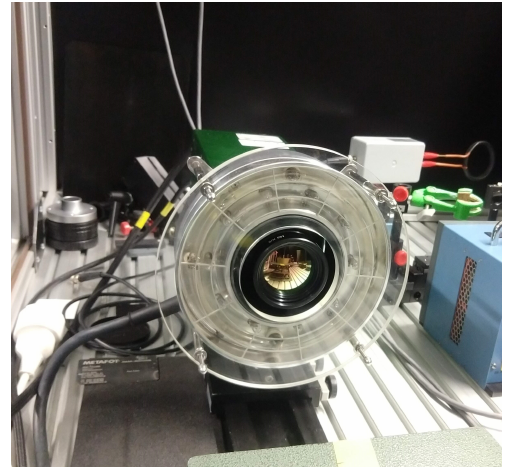
Figure 4. IR camera and circular